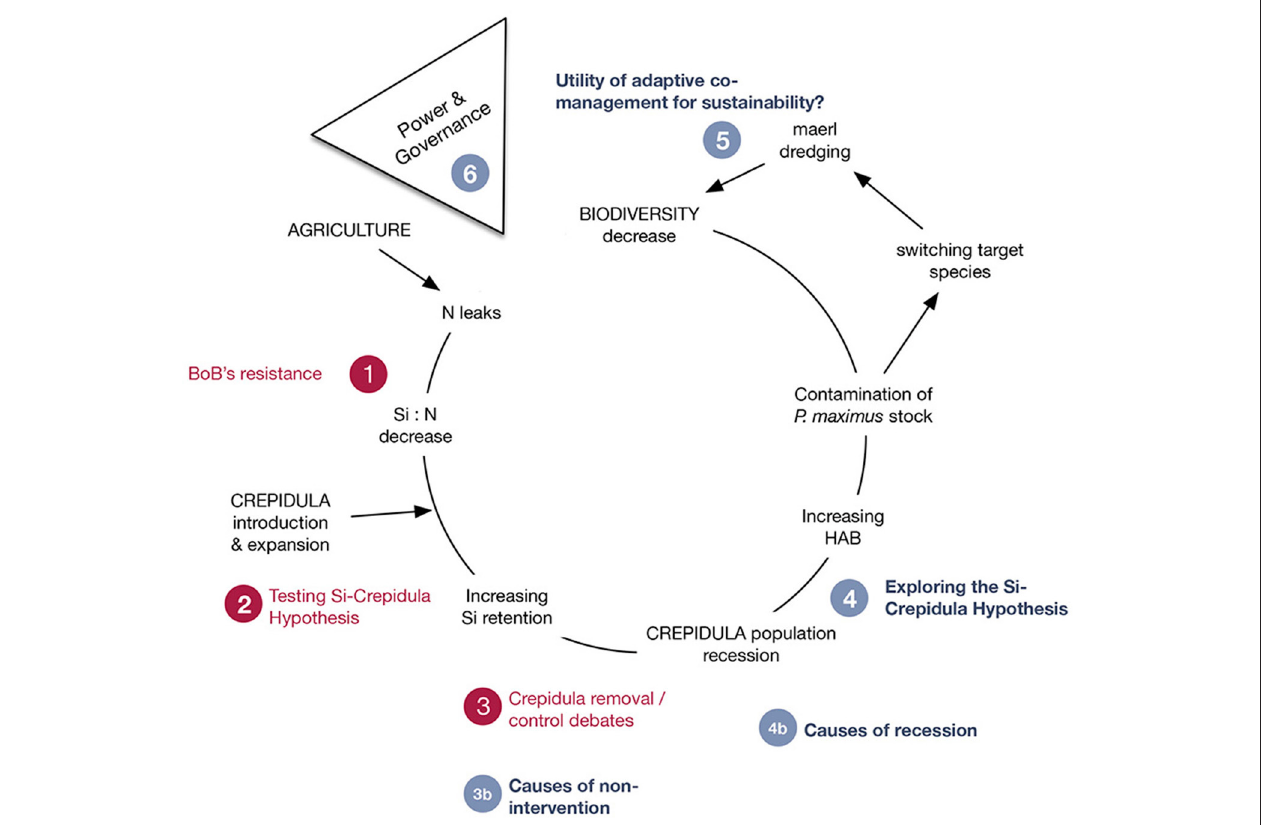
FIGURE 6 | Scientific questions raised today, for natural sciences concerning the causes of the recession of Crepidula (4 and 4b) and raised and addressed through an interdisciplinary approach involving the social sciences of politics, regarding the causes of the non-intervention 15 years ago concerning the possible control of Crepidula proliferation (3b), the fishing activities on maerl habitat and its impacts on biodiversity (5) and the relations between these fishing activities and agricultural activities on land, that question the governance of the land-ocean continuum